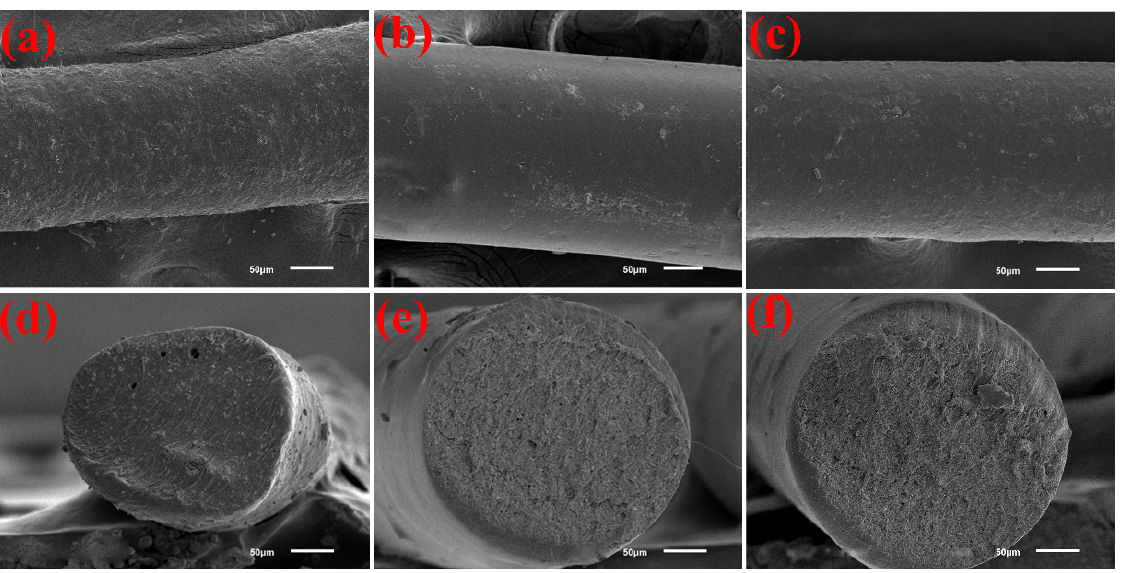
Figure 4. SEM images of the surface and fracture of YAG ceramic fiber with different TPU types and the ratios of TPU to ceramic powder: ( a , d ) surface and fracture of the ceramic fiber with the mass ratio of TPU-75A# to ceramic powder = 4:6, respectively; ( b , e ) surface and fracture of the ceramic fiber with the mass ratio of TPU-95A# to ceramic powder = 4:6, respectively; ( c , f ) surface and fracture of the ceramic fiber with the mass ratio of TPU-95A# to ceramic powder = 3:7, respectively.